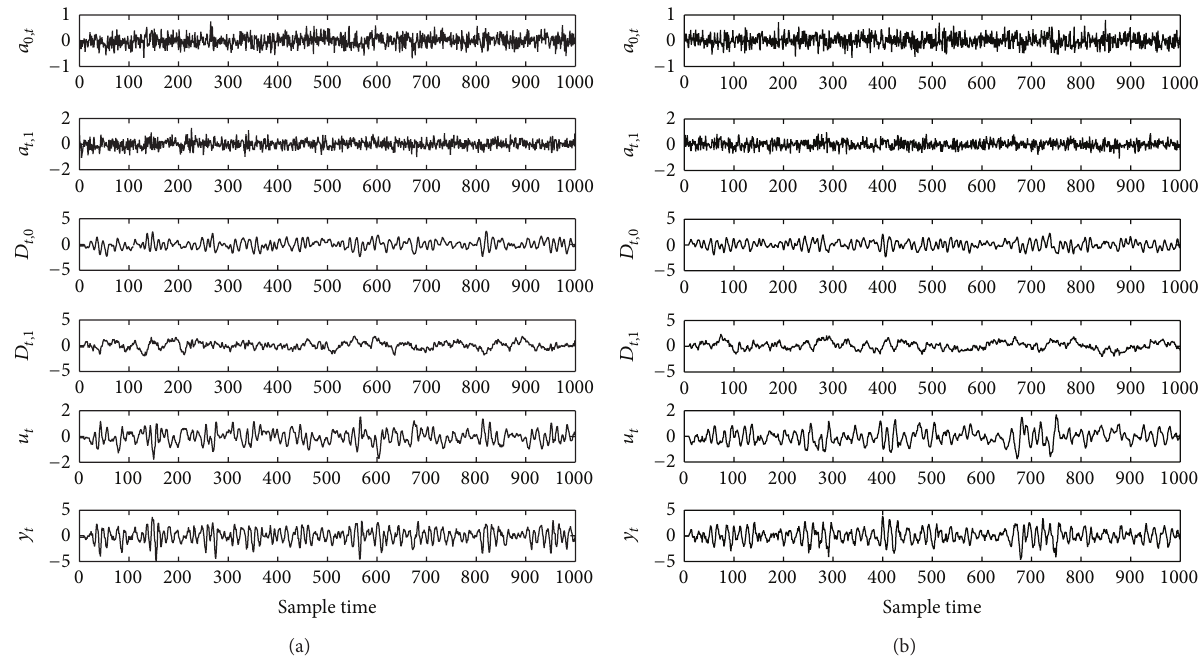
Figure 2: 1000 samples for the closed-loop nonlinear feedforward and feedback system subjected to measured and unmeasured disturbances. (a) 𝑏 = 3 , 𝑙 = 5 ; (b) 𝑏 = 5 , 𝑙 = 3 .